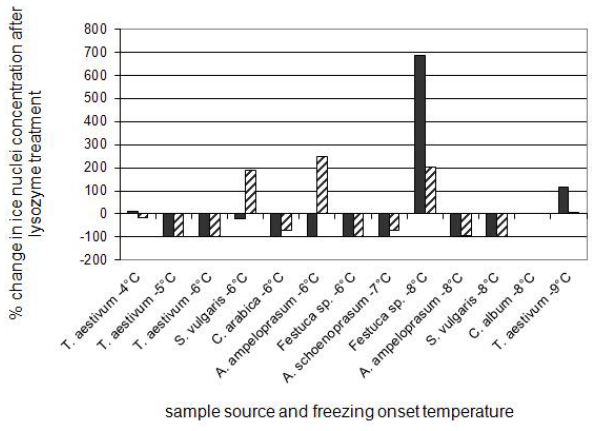
Fig. 4. Effect of lysozyme treatment on the abundance of ice nu- clei in spore suspensions. The effect is presented as the percent of change in the number of ice nuclei per mL of spore suspension at the freezing onset temperature (black bars) and at one degree below the freezing onset temperature (hatched bars) for each sample. There was 0% change in freezing behavior for spores from C. album for both